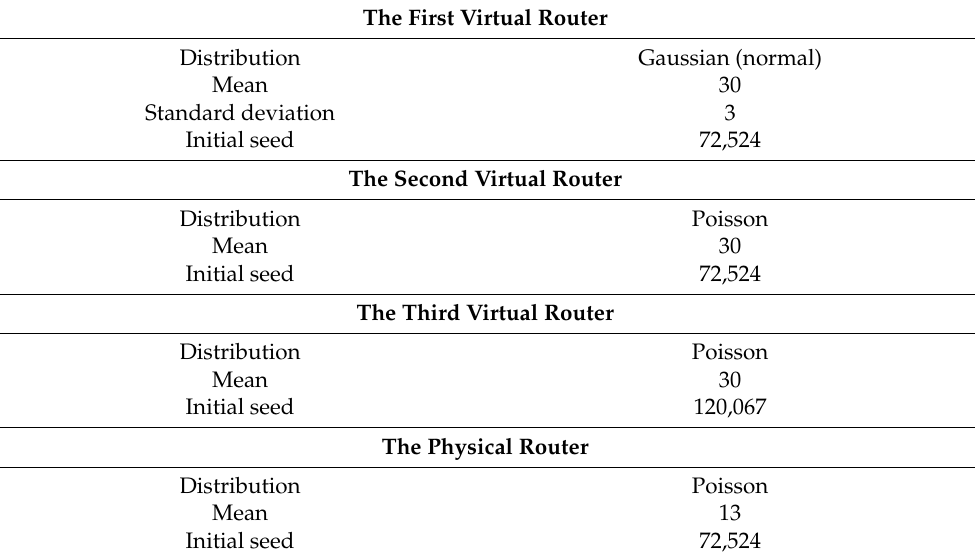
Table 2. Source block parameters for three virtual routers (CPU-450 MHz) and one physical router without virtualization (CPU-1400 MHz) for a service time 30 µ